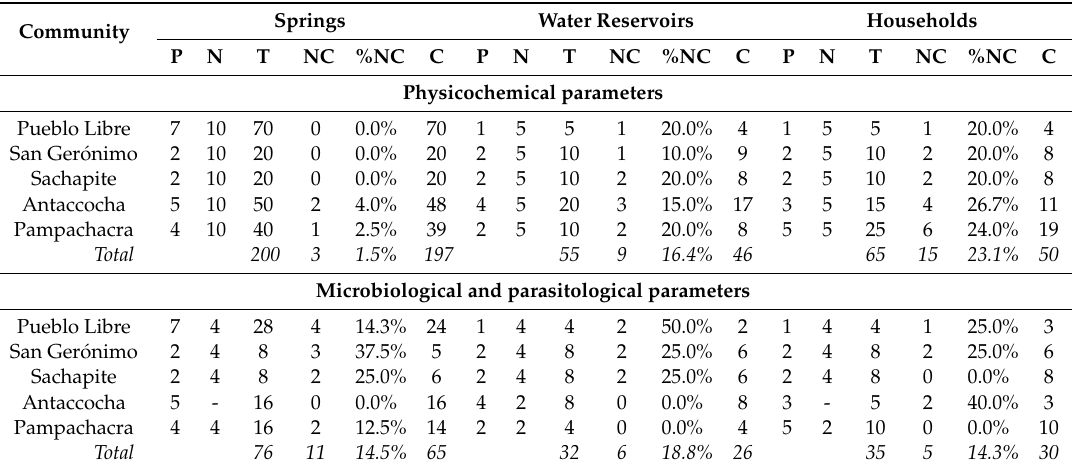
Table 3. Water quality at di ff erent monitoring